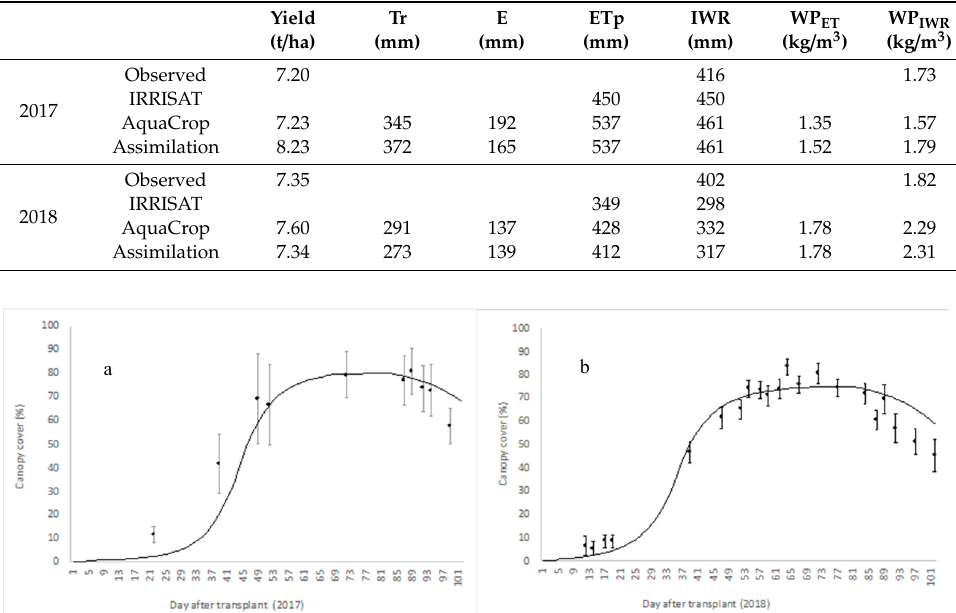
Figure 5. Linear correlation between tomato canopy cover simulated by AquaCrop and fractional cover retrieved by Sentinel-2 imagery in 2017 ( a ) and 2018 ( b ). Standard deviation (bars) and 1:1 line (dashed line) are reported. 3.3. Estimation of Crop Water Irrigation Requirements